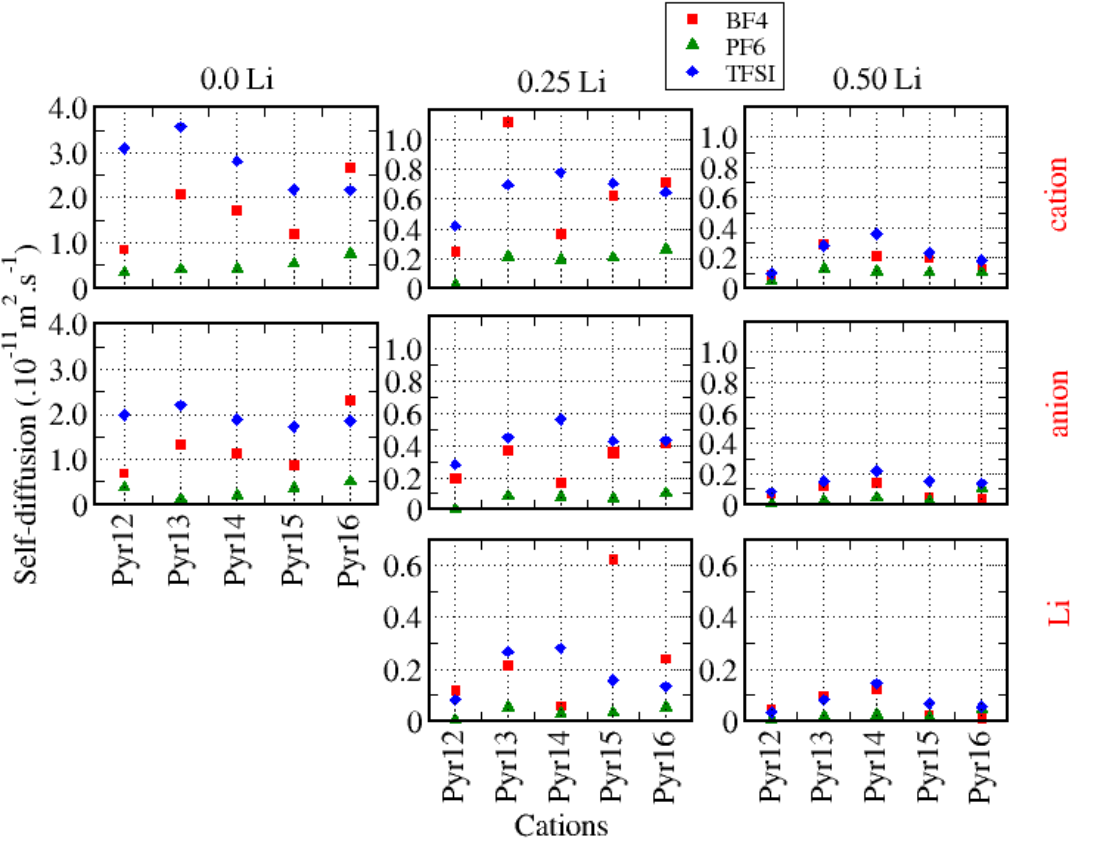
Figure 13. Self–diffusion of all species in the systems